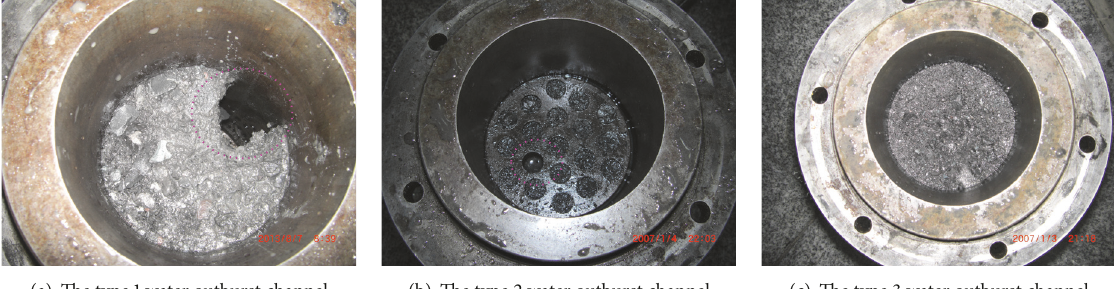
Figure 7: Outburst channel types at instable seepage